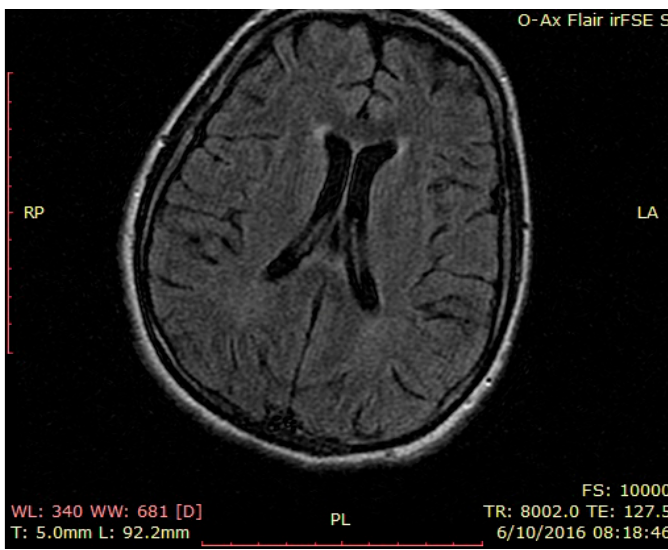
Figure 6. Second brain MRI, FLAIR images, axial parietal image.